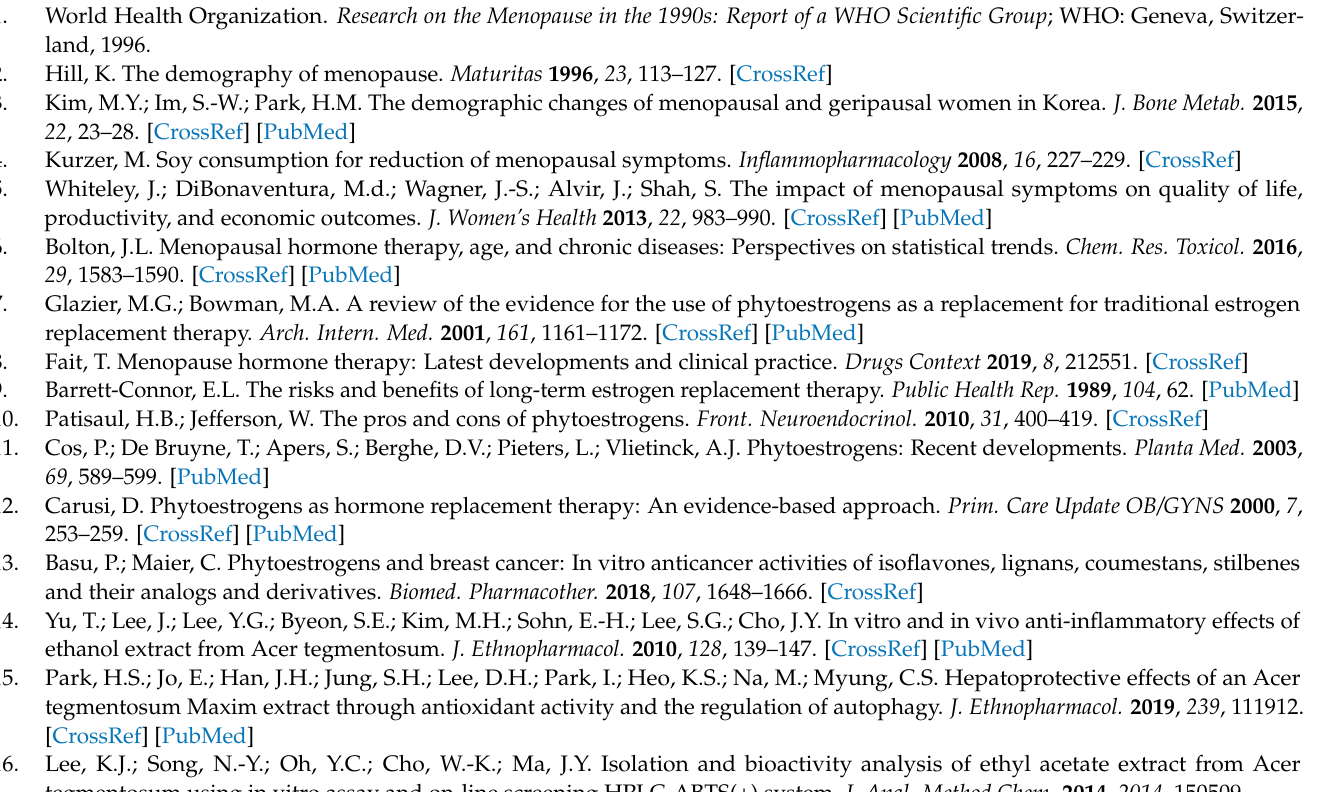
800 MHz), Figure S2: 13 C NMR spectrum of 1 (CD 3 OD, 200 MHz), Figure S3: HPLC chromatogram and UV and MS data of LC/MS for compound 1 , Figure S4: 1 H NMR spectrum of 2 (CD 3 OD, 800 MHz), Figure S5: HPLC chromatogram and UV and MS data of LC/MS for compound 2 , Figure S6: 1 H NMR spectrum of 3 (CD 3 OD, 800 MHz), Figure S7: 13 C NMR spectrum of 3 (CD 3 OD, 200 MHz), Figure S8: HPLC chromatogram and UV and MS data of LC/MS for compound 3 , Figure S9: 1 H NMR spectrum of 4 (CD 3 OD, 800 MHz), Figure S10: HPLC chromatogram and UV and MS data of LC/MS for compound 4 , Figure S11: 1 H NMR spectrum of 5 (CD 3 OD, 800 MHz), and Figure S12: HPLC chromatogram and UV and MS data of LC/MS for compound 5